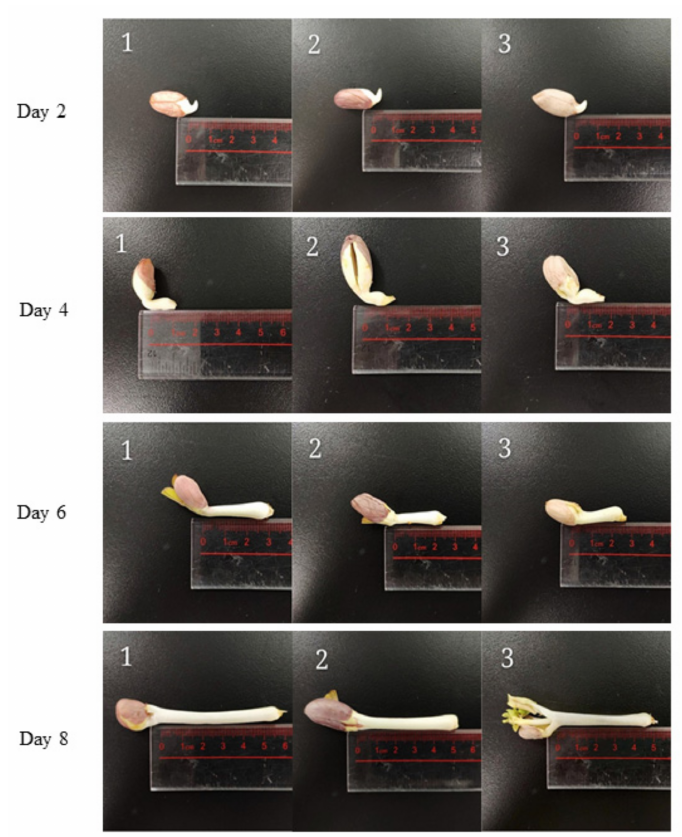
Figure 2. Development and length of the radicle of different varieties of peanuts of different varieties namely, (1) Silihong, (2) Silihei, and (3) Xiaobaisha during